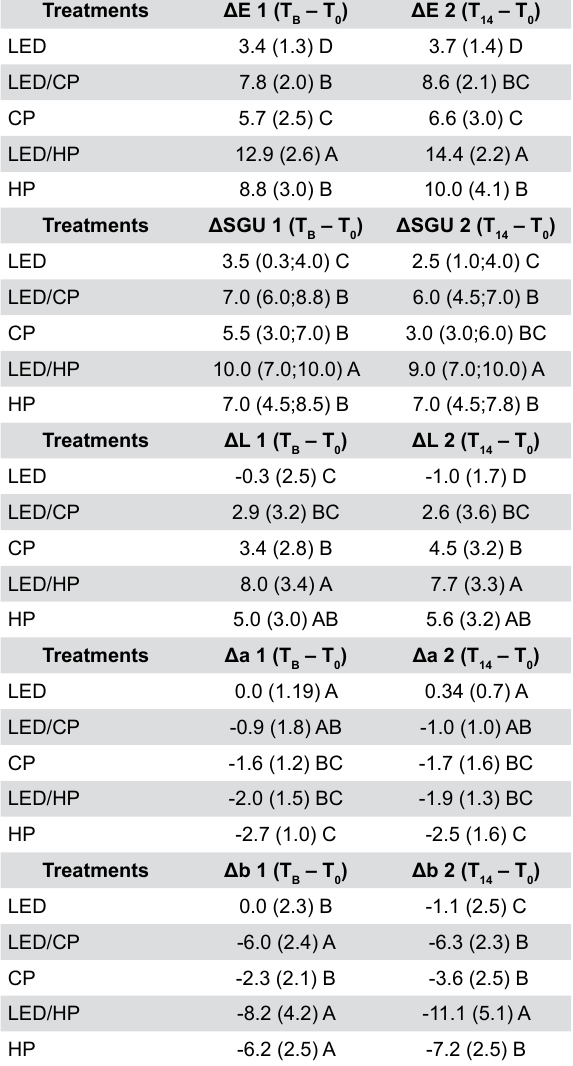
Table 2- Mean ΔE, ΔL, Δa and Δb1 (T values and standard deviations, and medians (minimum and